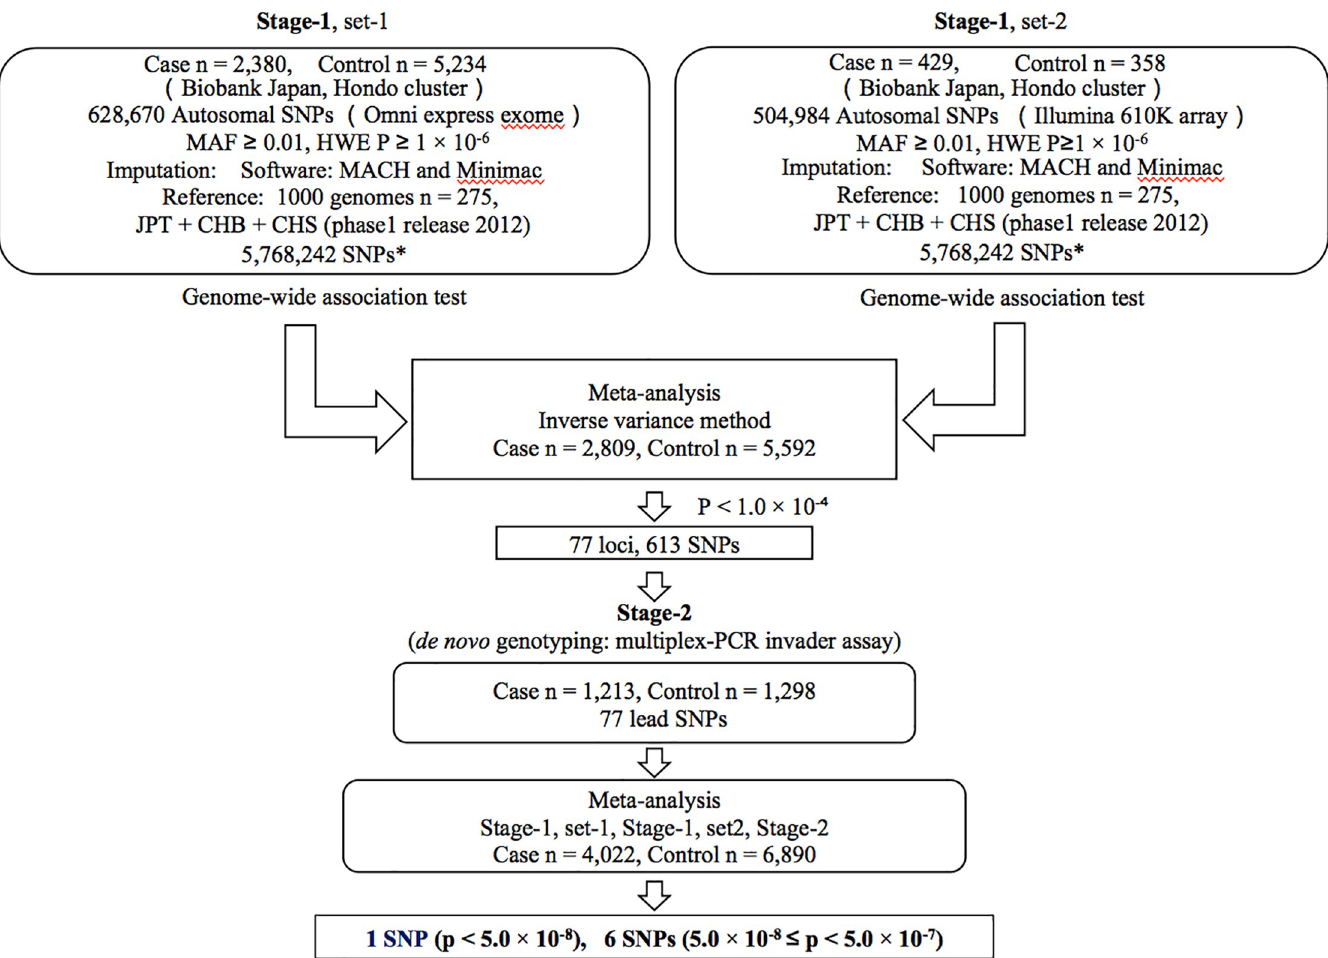
Fig 1. Outline of this study. � r 2 > 0.7 in both studies, SNP; single nucleotide polymorphism, MAF; minor allele frequency, HWE P; Hardy-Weinberg Equilibrium test P, RSQ, r